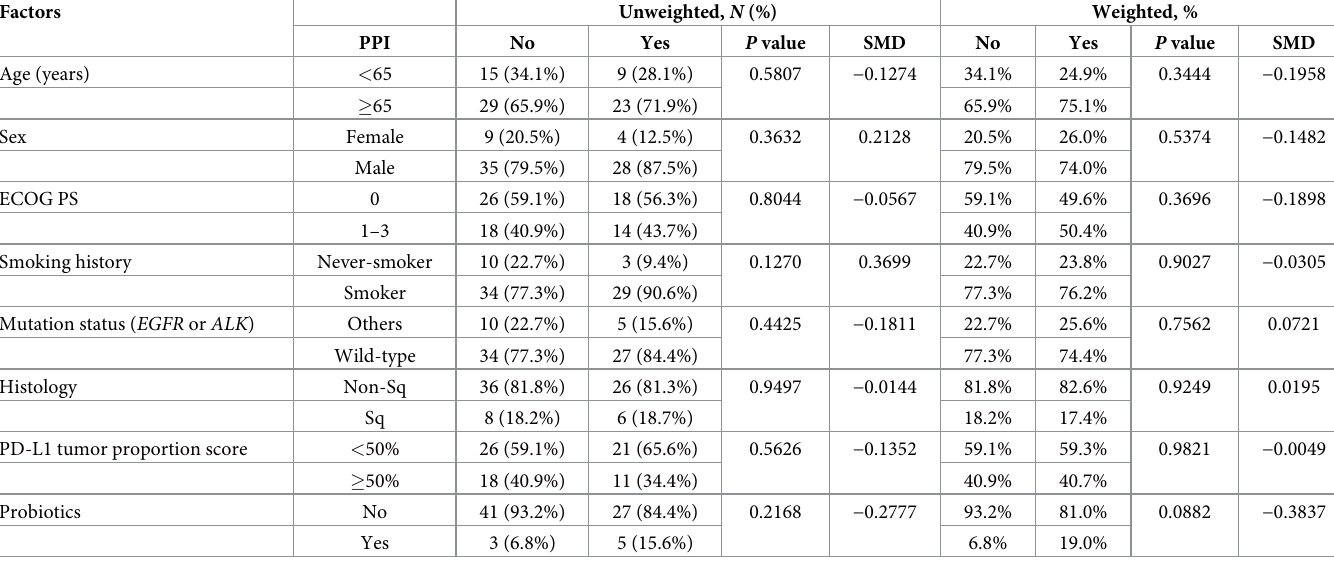
Table 2. Characteristics of the patients according to the use of PPIs before and after weighting. Factors